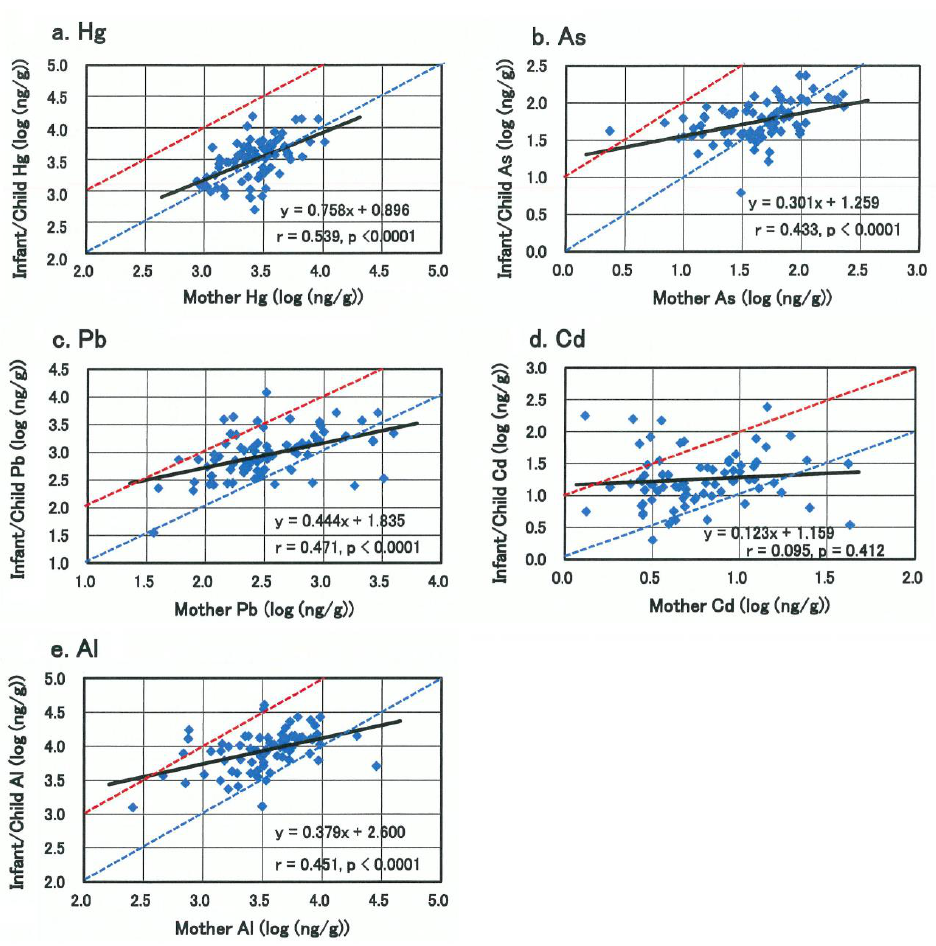
Figure 1. Relationship of toxic metal concentrations in scalp hairs between infants/children and their mothers. ( a ) Mercury, ( b ) Arsenic, ( c ) Lead, ( d ) Cadmium, ( e ) Aluminum. Dotted blue line and red line represent the toxic metal concentrations in infants/children equal to and 10 times higher than those in their mothers,